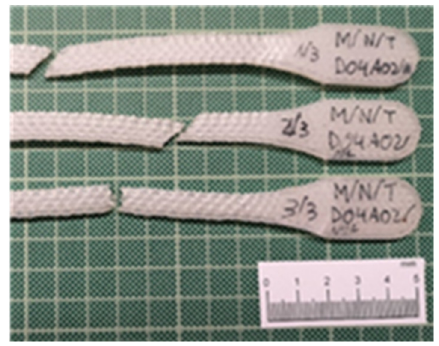
Figure 15. Triangular internal structure of M/N/T specimens.